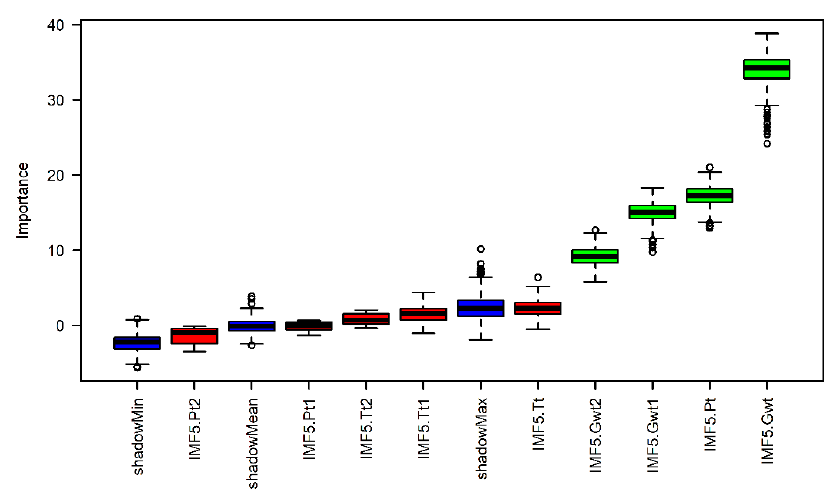
Figure 4. Box result plot by Boruta input selection algorithm.